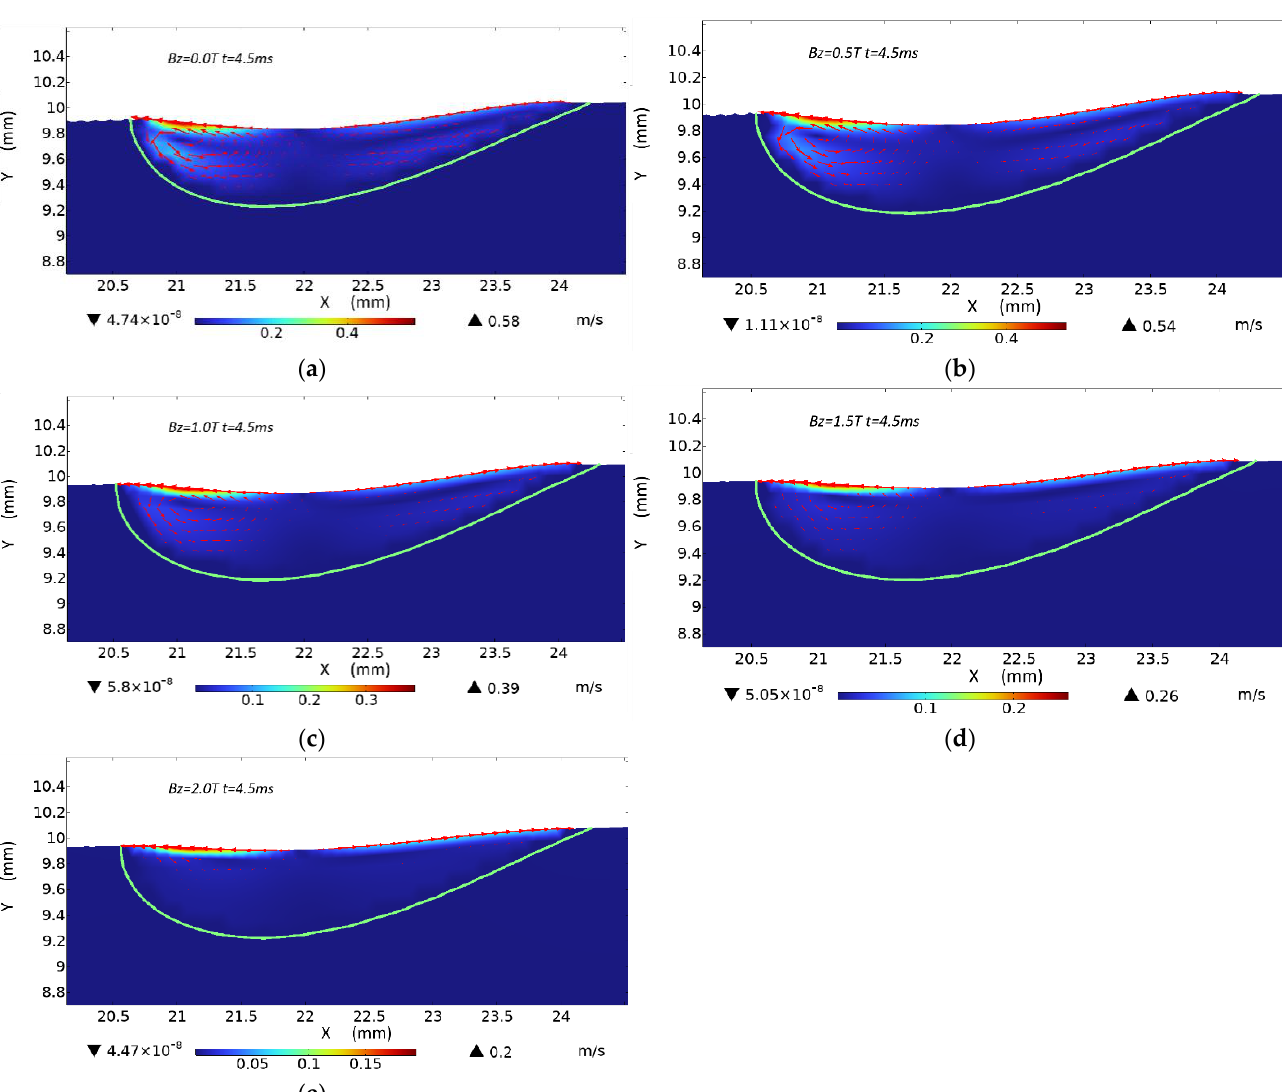
Figure 4. Temperature field distribution on the melting surface at different magnetic flux densities (t = 4.5 s).